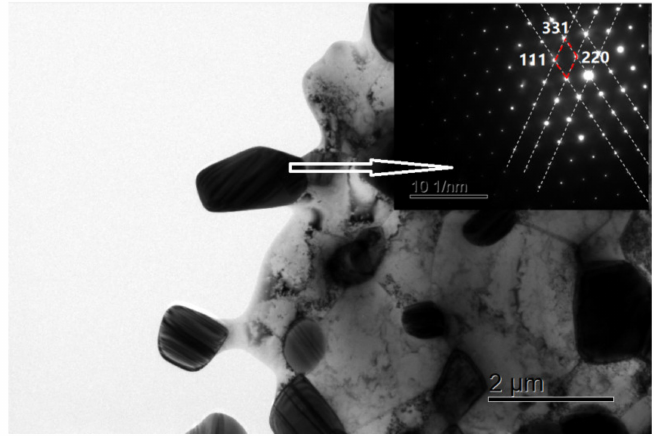
Figure 7. TEM (transmission electron microscope) image of BSS by HIP (hot isostatic pressing) at 1100 ◦ C.